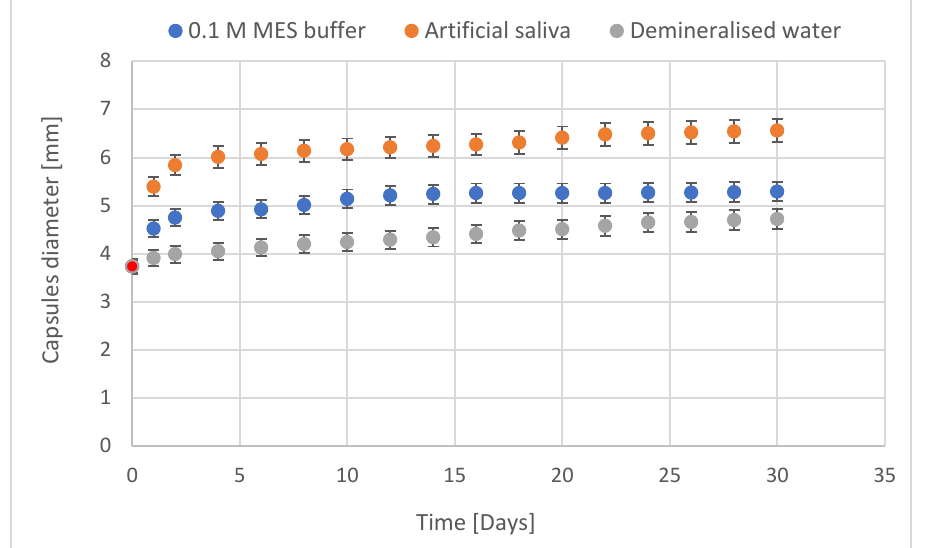
Figure 6. GO-AMOX alginate capsules stability expressed by their diameter (T = 37 °C). Initial capsules’ diameter was 3.735 ± 0.224 mm (a red point).